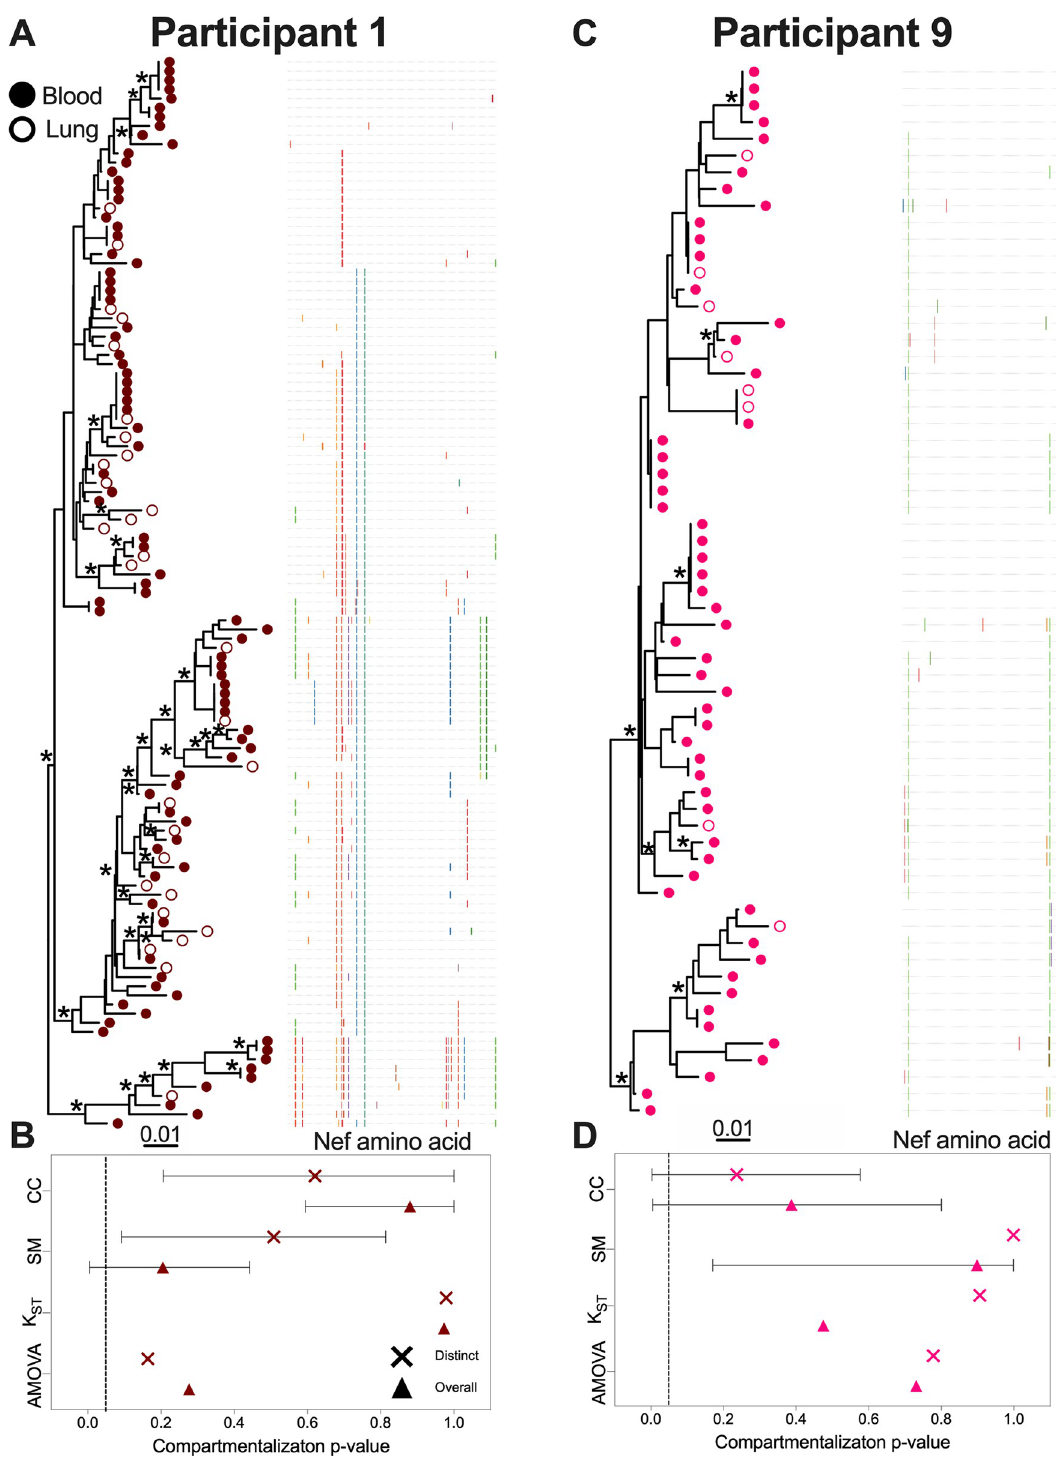
Fig 4. Within-host phylogenies and compartmentalization results for participants 1 and 9. Legend as in Fig 2.